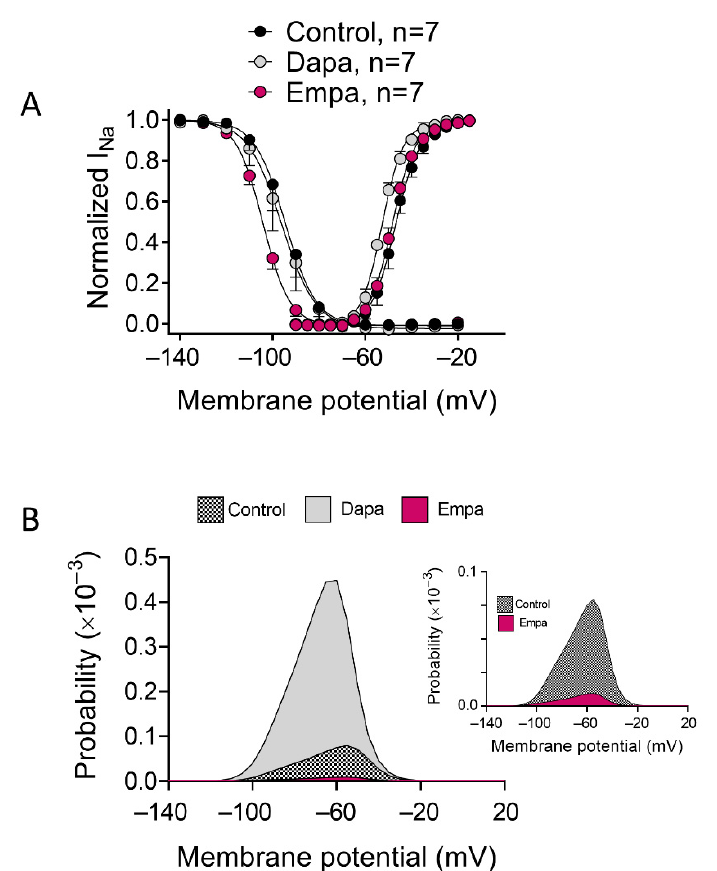
Figure 2. Dapa and empa modified voltage dependence of I Na activation and inactivation, as well as window current. ( A ) Activation and inactivation curves for I Na recorded in the three experimental groups. The solid lines represent the fit of a Boltzmann function. Each point is the mean ± SEM of the “n” experiments indicated in the figure. ( B ) Probability of being within the window current of hiPSC-CMs incubated with dapa or empa or not incubated. Probability of being within that window current for control and empa is also shown in the inset on an enlarged scale.